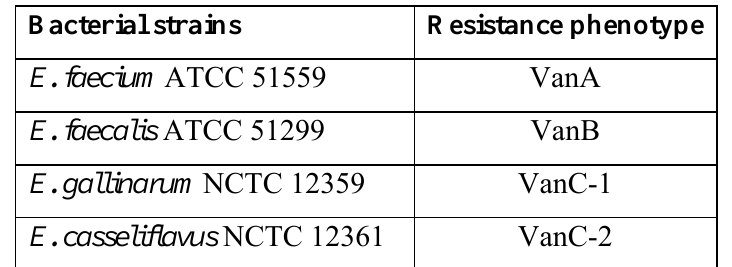
Table 5. List of the standard bacterial strains used in the study as controls